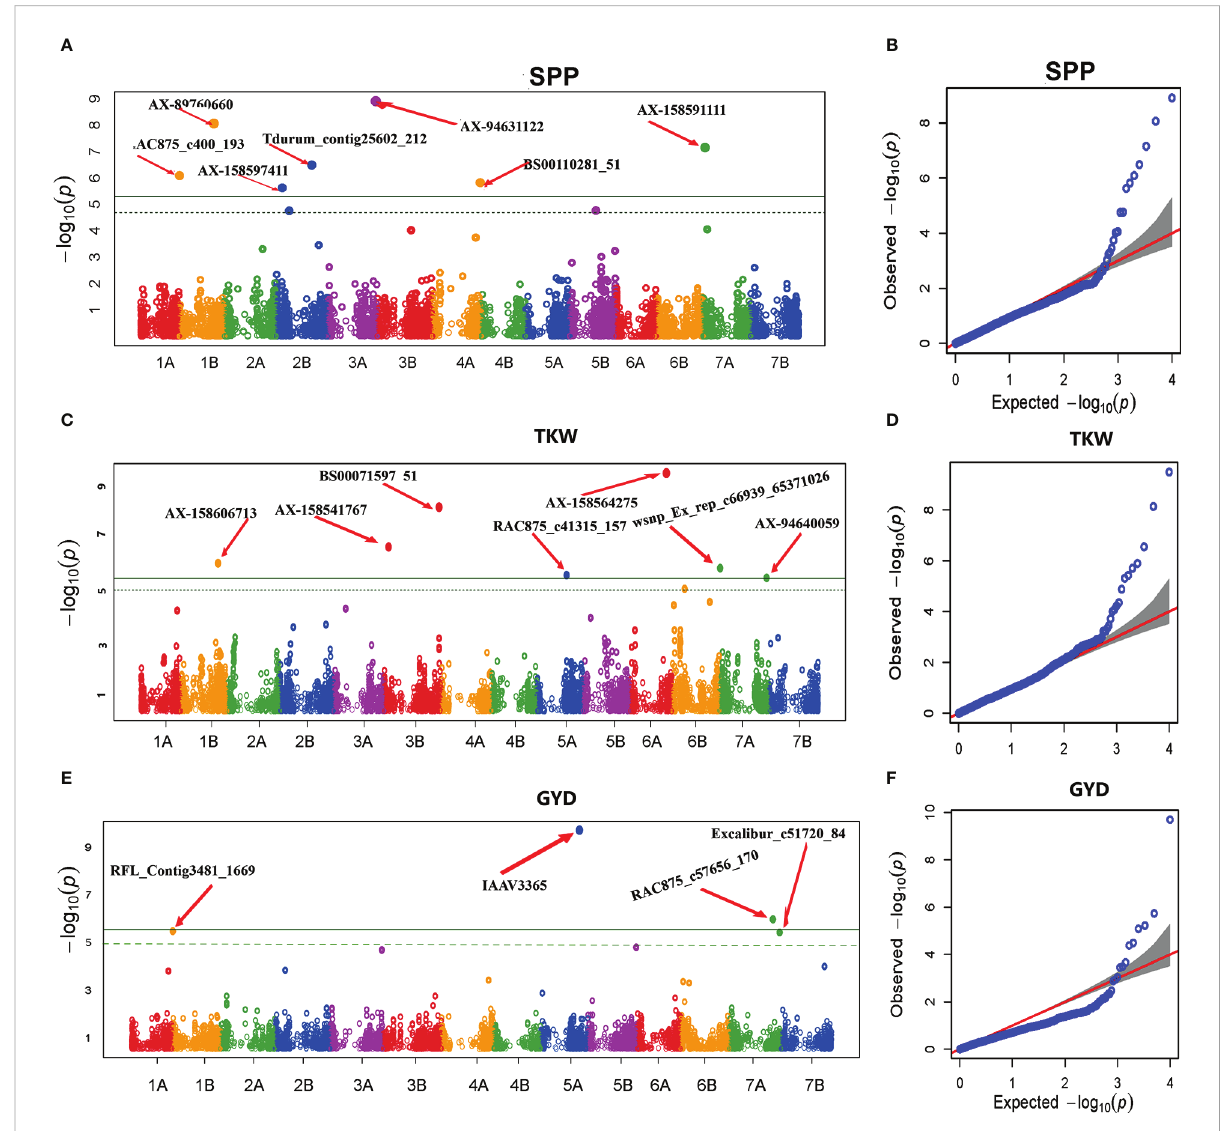
FIGURE 7 Manhattan and Q-Q plots of GWAS scan for SPP (A, B) , TKW (C, D) , and GYD (E, F) generated based on the combined data from fi ve locations. For the Manhattan plots, the y-axis represents -log10 (p) of the traits, while the x-axis represents the relative positions of the SNP markers on each chromosome. SPP, Number of spikelets per spike; TKW, Thousand kernel weight; GYD, Grain